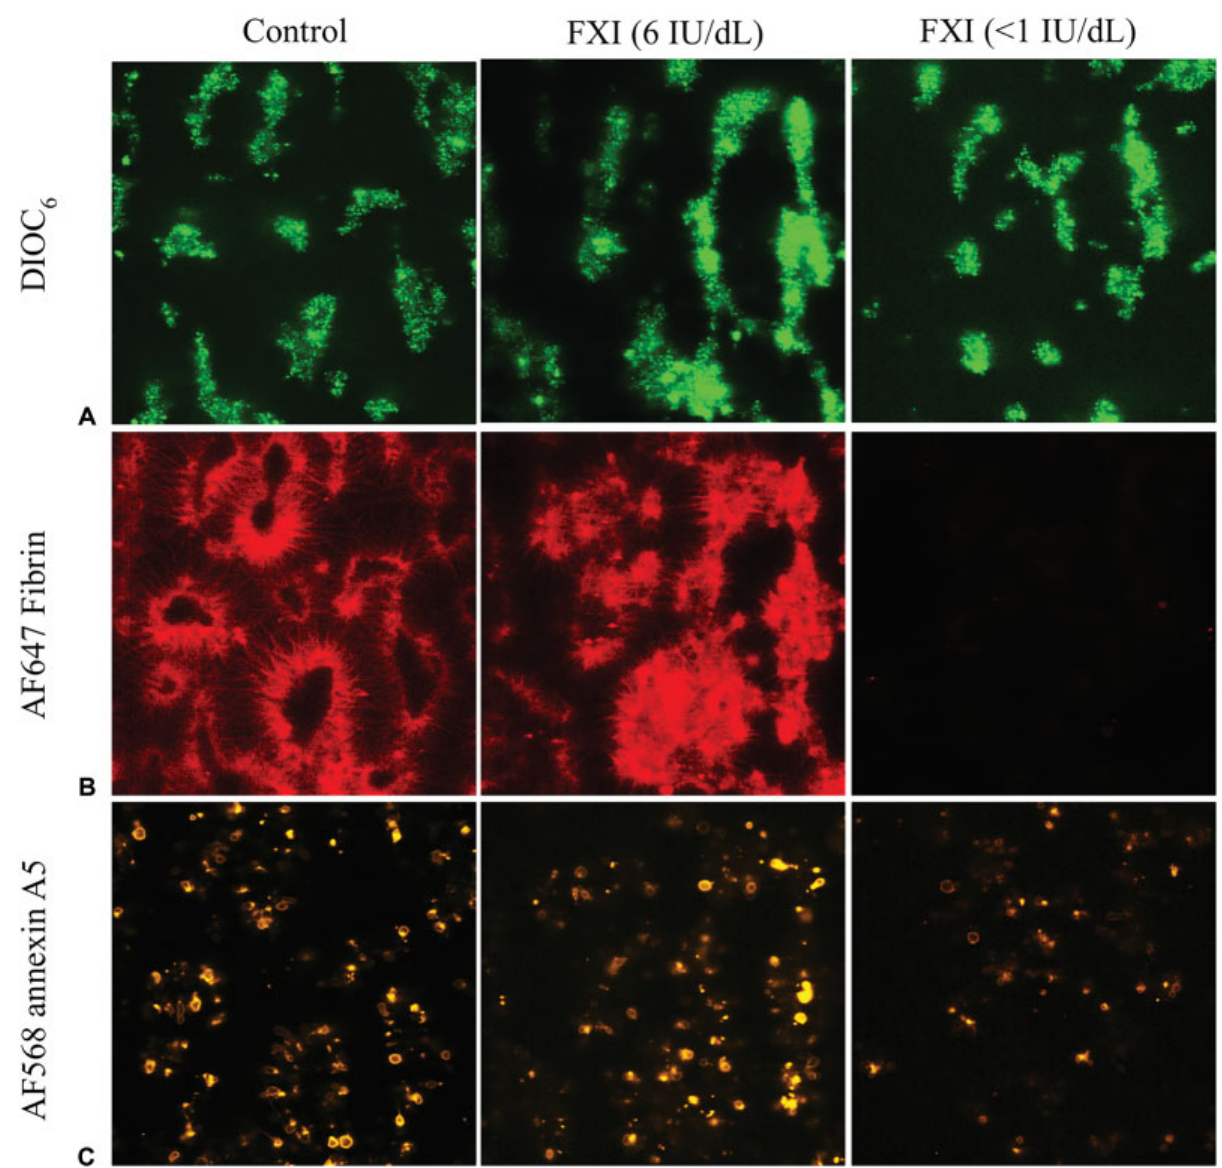
Fig. 3 Impaired fi brin-thrombus formation in whole blood from patients with factor XI de fi ciency. Whole blood samples from representative controls and indicated patients (FXI levels 6IU/dL and < 1IU/dL, respectively) were perfused under recalci fi cation over microspots of collagen (cid:6) TF at a wall-shear rate of 1,000s (cid:5) 1 for 11minutes. Real-time recorded bright fi eld microscopic images were analyzed for fi brin- thrombus formation ( ► Fig. 4 ). Fluorescence images at endstage were taken for measurement of platelet deposition ( A , DiOC 6 ), AF647- fi brin formation ( B ), and phosphatidylserine exposure ( C , AF568-annexin A5). Representative images (106 (cid:4) 106µm) are shown, captured from microspots of collagen/TF. TF, tissue